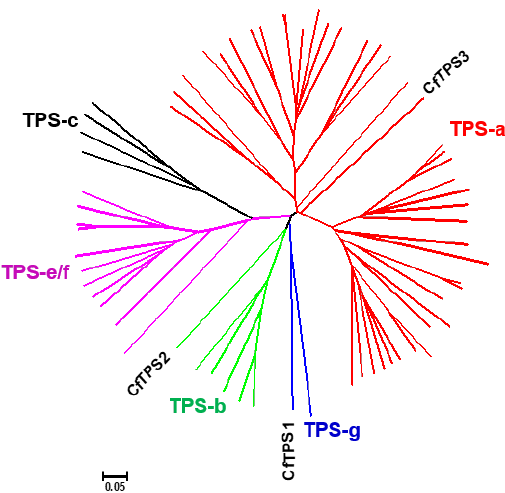
Figure 5. Phylogenetic analysis of three CfTPS and selected terpene synthases ( TPSs ) from the dicot Arabidopsis thaliana and the monocot Oryza sativa based on estimation of pair-wise distances at the amino acid level. Clusters corresponding to five TPS subfamilies ( TPS-a, TPS-b, TPS-c, TPS-g, and TPS-f ) are apparent. The genes belonging to the TPS-a, TPS-b, TPS-c, TPS-g, and TPS-e/f subfamilies were color-coded in red, green, black, blue, and purple, respectively. The Clustal W 2.0 algorithm was used for the alignment. Trees were inferred with the neighbor-joining (NJ) method and n = 1000 replicates for bootstrapping.